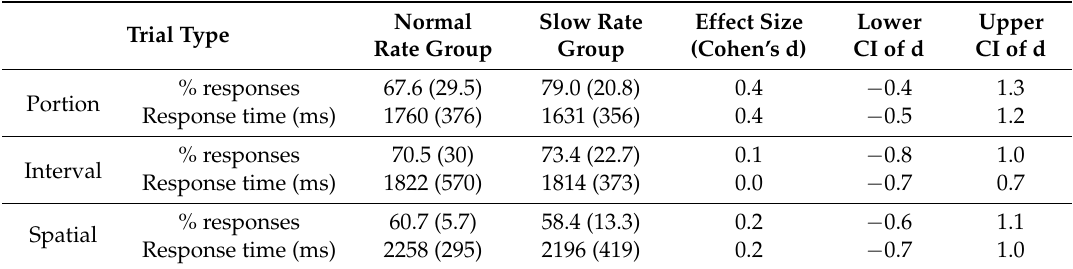
Table 2. Percentage correct and response time on the memory for recent eating task (performed in MRI scanner) (mean;